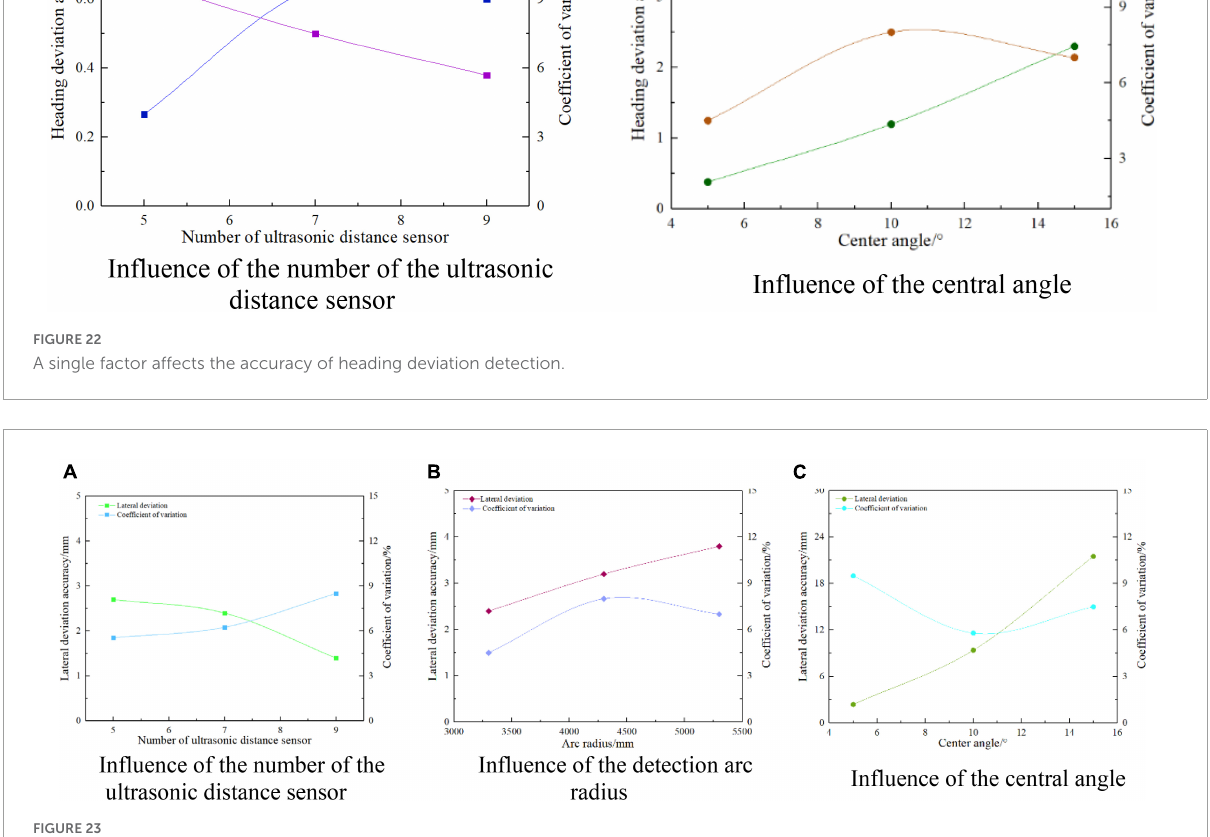
FIGURE23 A single factor affects the accuracy of lateral deviation